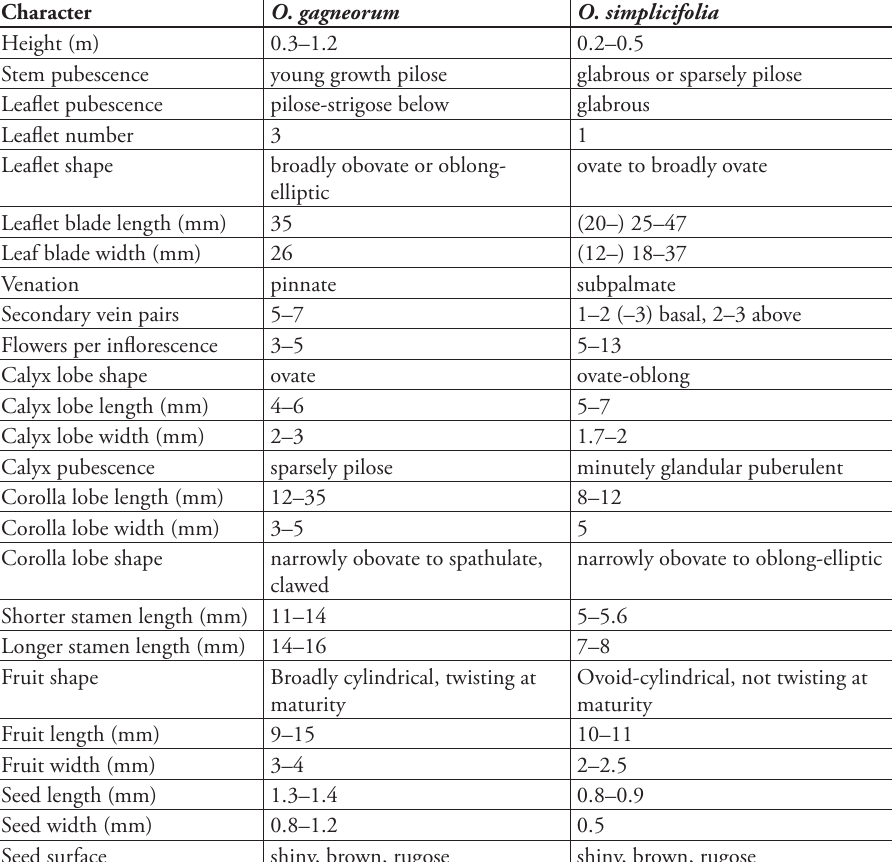
table 1. Distinguishing morphological features of Oxalis gagneorum and O. simplex